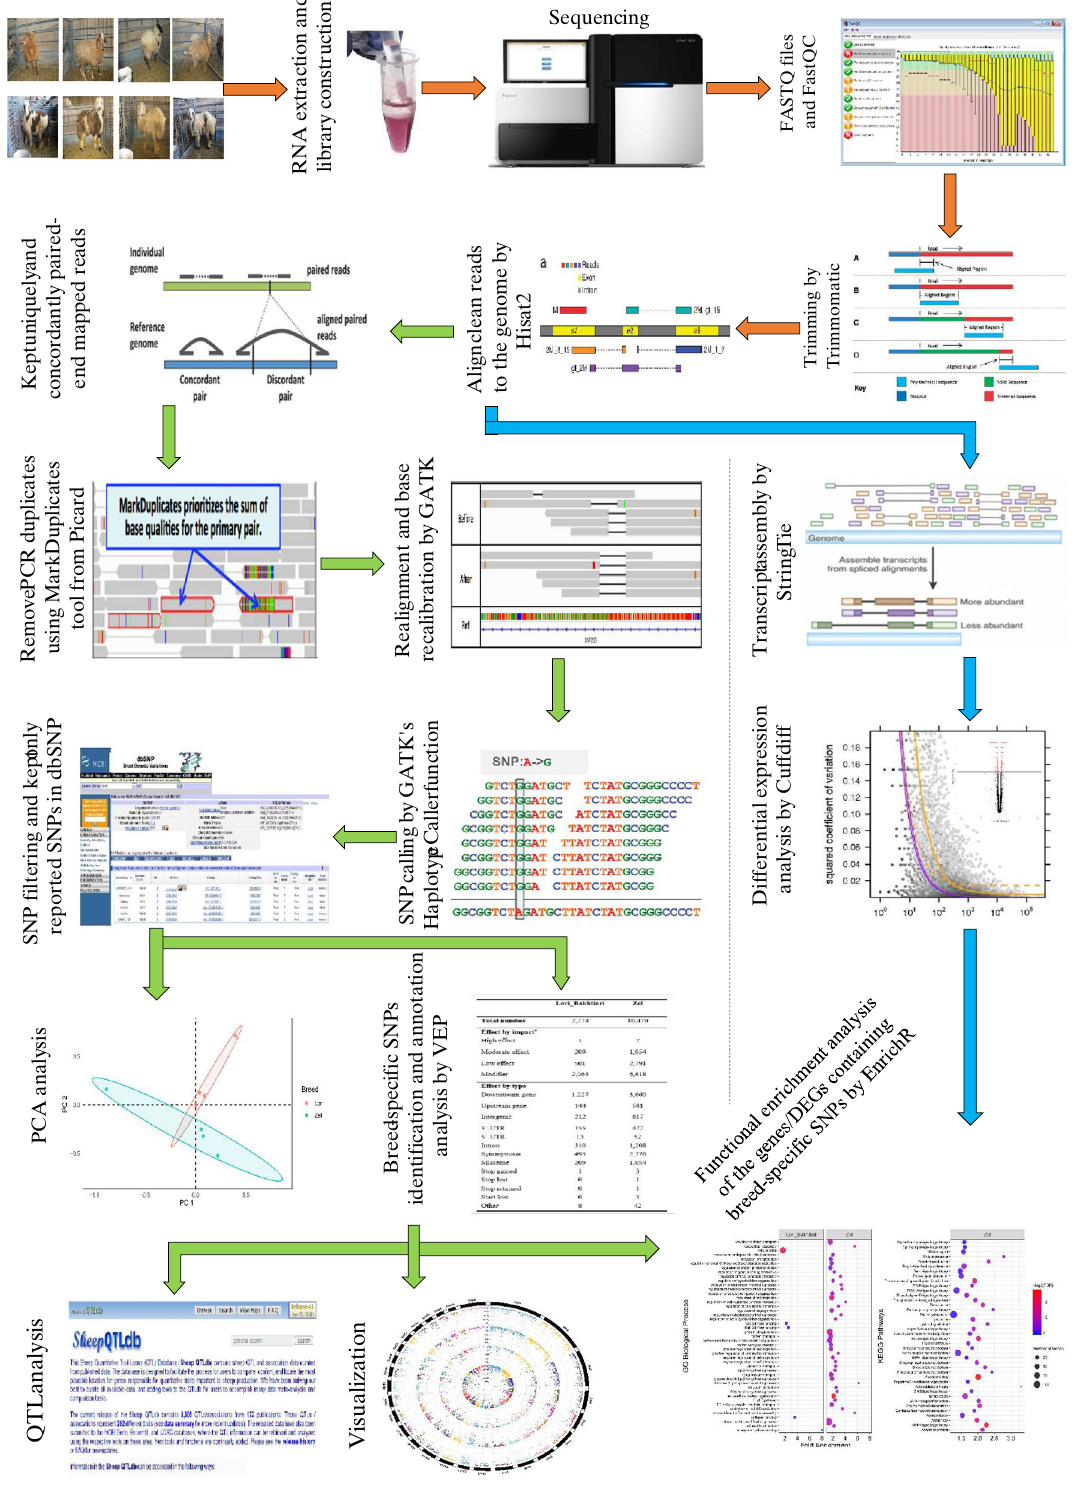
Figure 2. The bioinformatic pipeline for SNP calling, differential expression analysis and functional enrichment